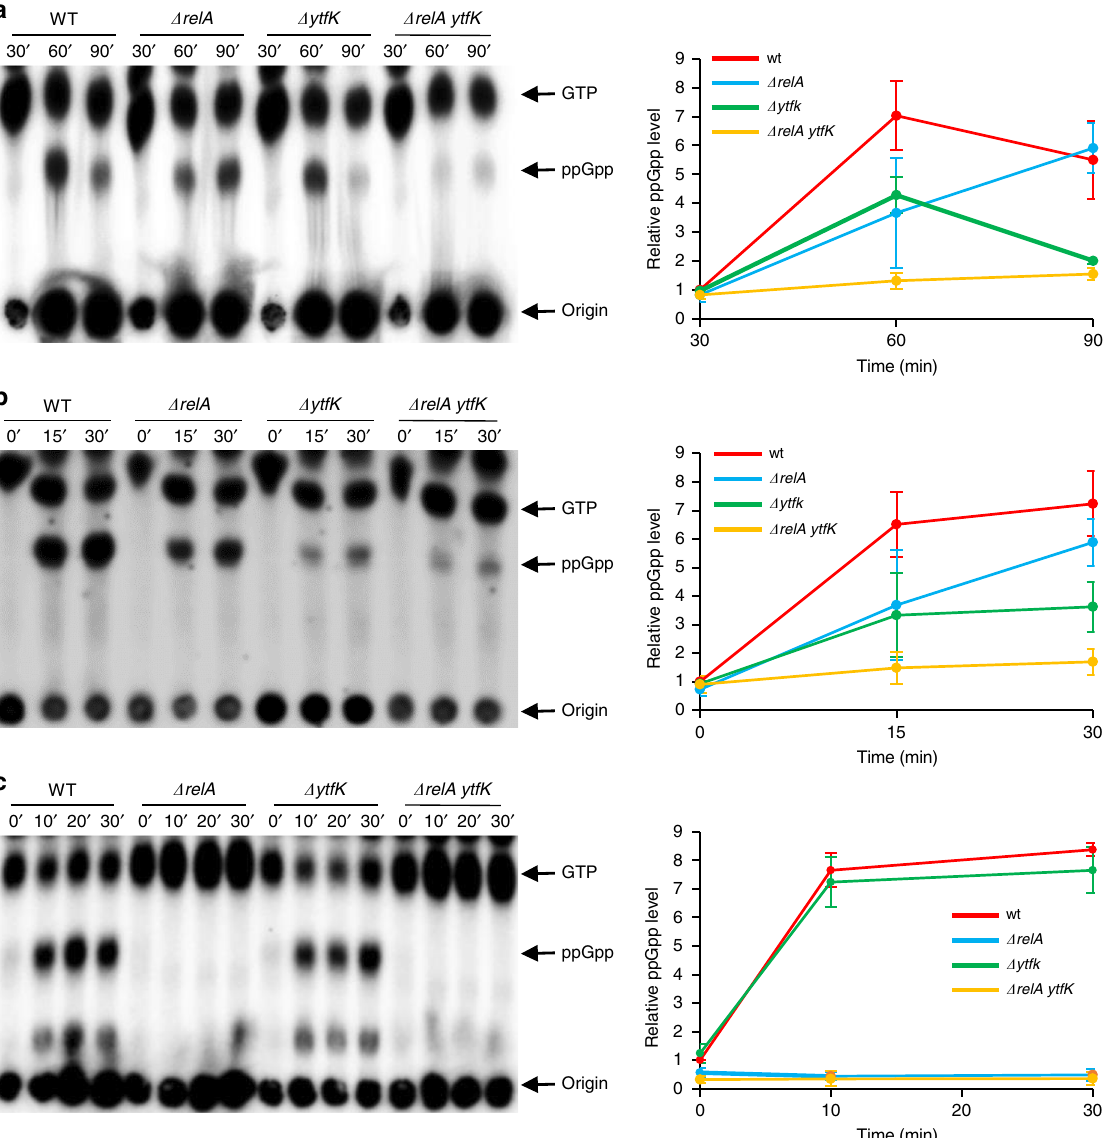
Fig. 3 y tfK is required for normal accumulation of (p)ppGpp during phosphate and fatty acid starvation. Exponentially growing cells of MG1655 (WT) and isogenic deletion strains, Δ relA , Δ ytfK , and Δ relA ytfK were challenged for different starvations. Samples were taken at the indicated time, after being washed and resuspended in low-phosphate medium to induce phosphate starvation ( a ), after addition of 250 µ g/mL cerulenin to induce fatty acid starvation ( b ), and after addition of 500 µ g/mL L-Valine to induce amino acid starvation ( c ) (see the Methods section). Nucleotides were extracted and separated by TLC. Representative autoradiograph of the TLC is shown on the left, and quanti fi cation is presented on the right panel. Error bars indicate the standard deviations of averages of four independent experiments for phosphate starvation, six independent experiments for fatty acid starvation, and three independent experiments for amino acid starvation. Source data are provided as a Source Data fi